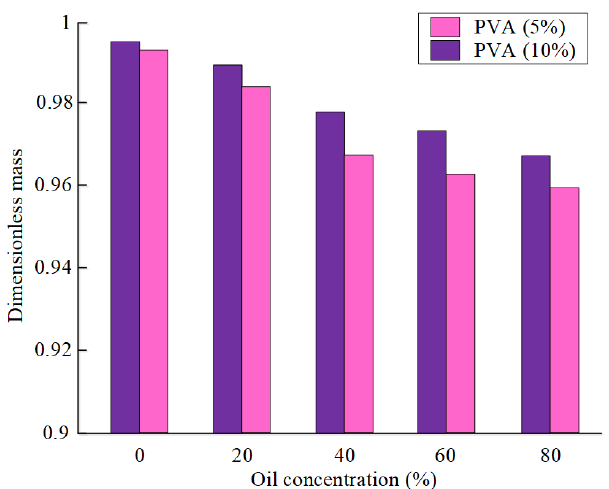
Figure 5. Masses of fuel pellets after deformation, reduced to their initial mass, at different concen- trations of an aqueous solution of PVA [109].